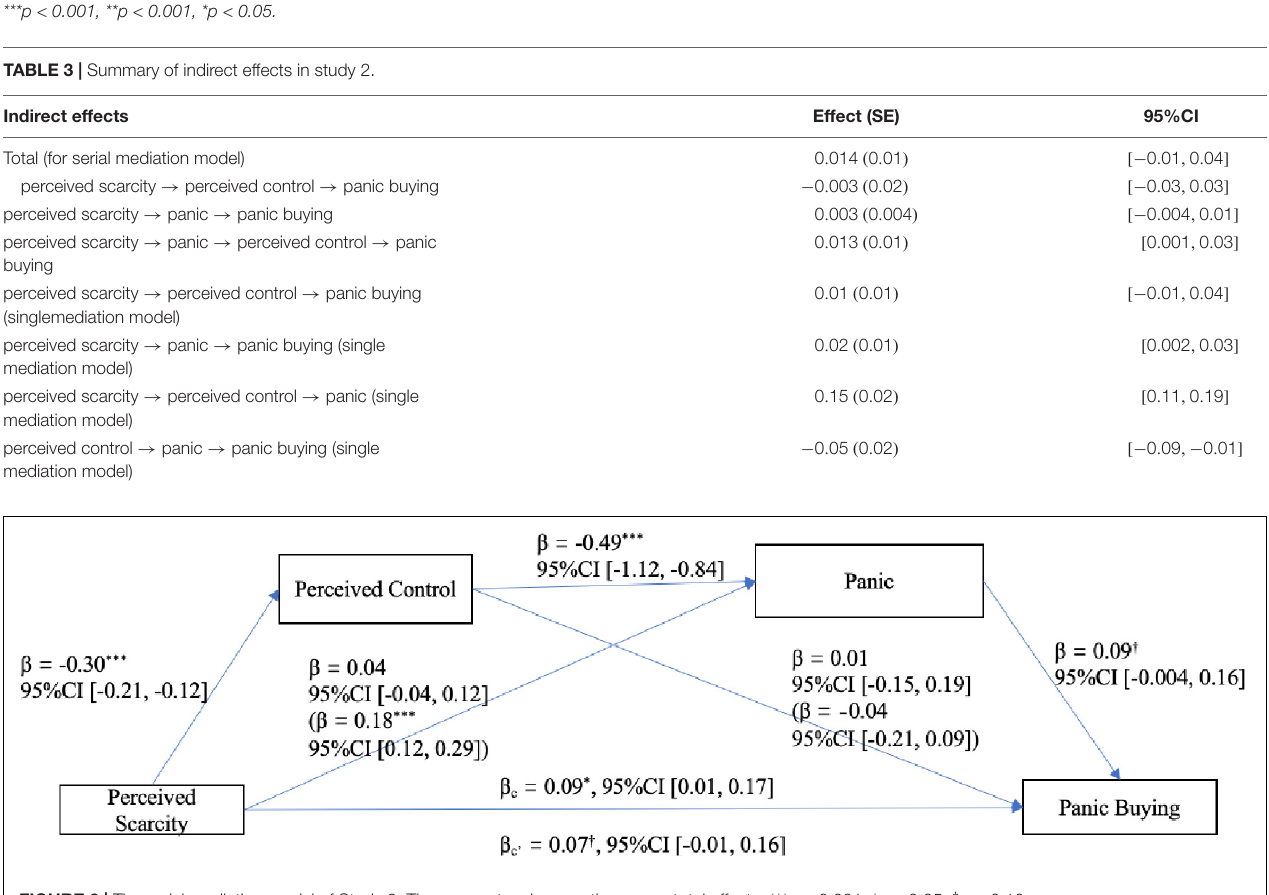
FIGURE 3 | The serial mediation model of Study 2. The parameters in parentheses are total effects. *** p < 0.001, * p < 0.05, † p <